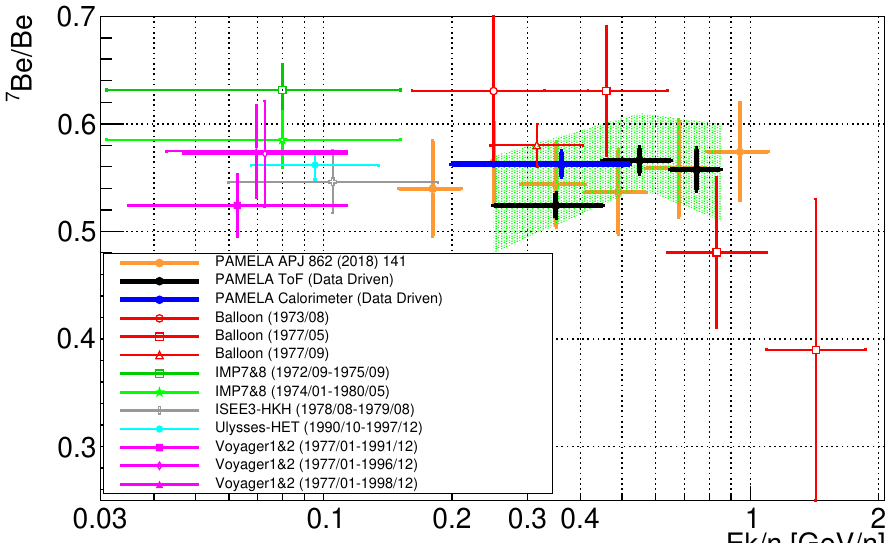
Figure 7. Results of the data-driven measurement of the 7 Be/Be fraction compared with previous experimental results and with a Monte Carlo based analysis of PAMELA [9] (orange dots). The green shaded contour is the systematic uncertainty inferred for the data-driven analysis.